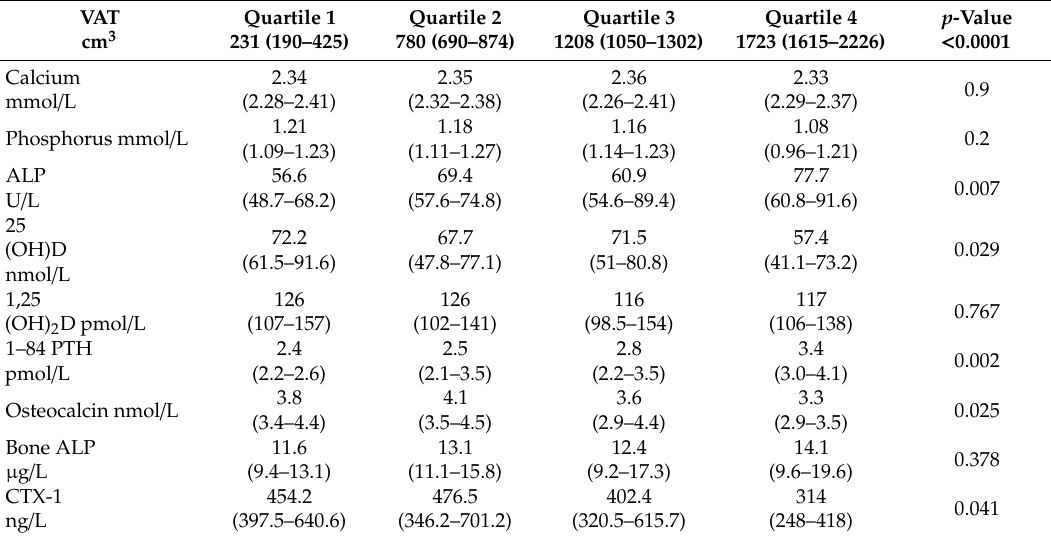
Table 2. Participant biochemical profile by VAT quartiles; median (interquartile range) n = 19 / quartile.